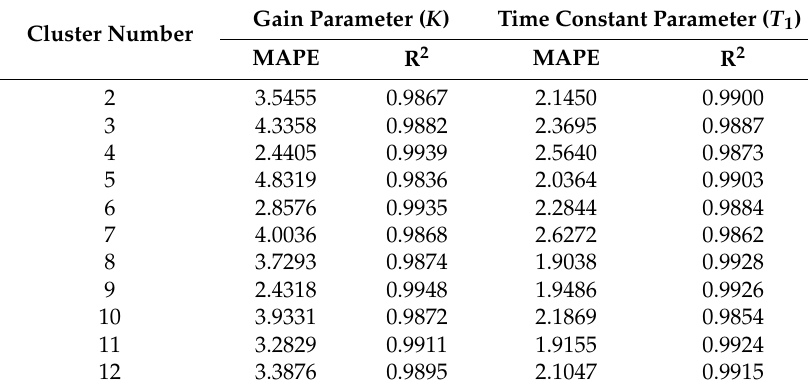
Table 2. Mean absolute percentage error (MAPE) and R 2 values with the di ff erent number of clusters for the ANFIS model (first test network).